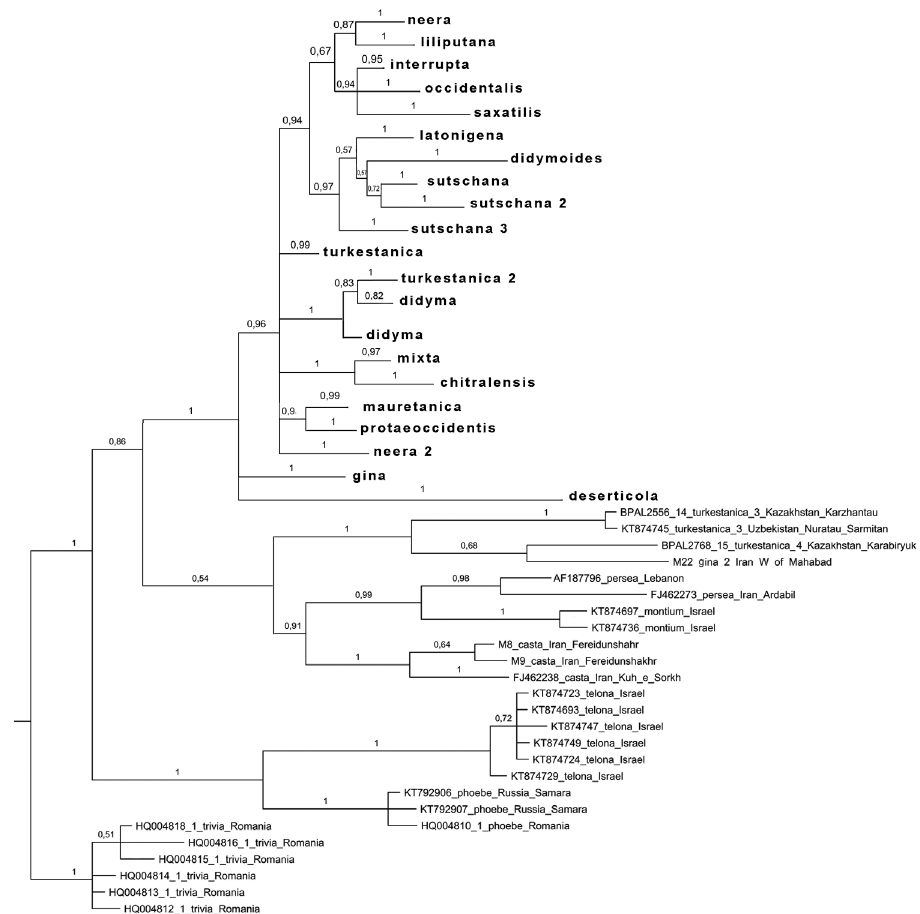
Figure 2. The Bayesian tree of Melitaea based on analysis of the cytochrome oxidase subunit I ( COI ) gene. Numbers at nodes indicate Bayesian posterior